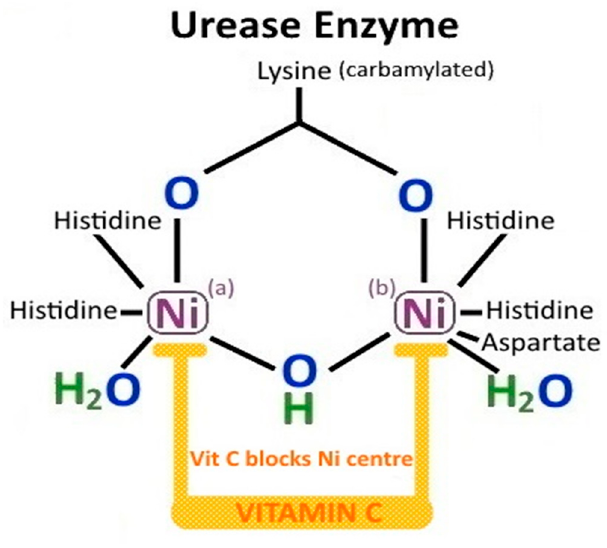
Figure 7. Inhibition of H. pylori urease by vitamin C [137].